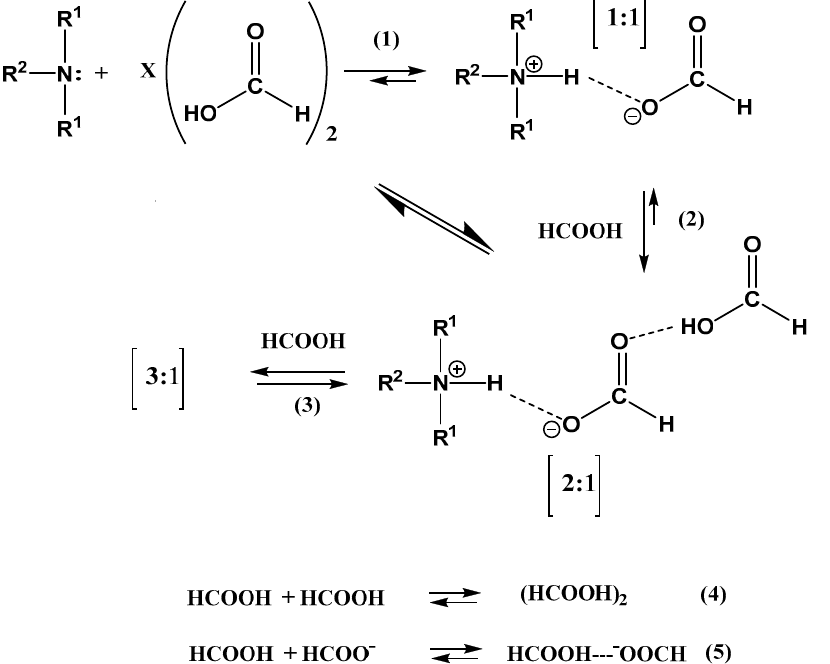
Figure 5. Suggested reaction scheme for the formation of the “ionic liquid”. Reprinted with permis- sion from Ref. [17]. Copyright 2016 American Chemical Society.